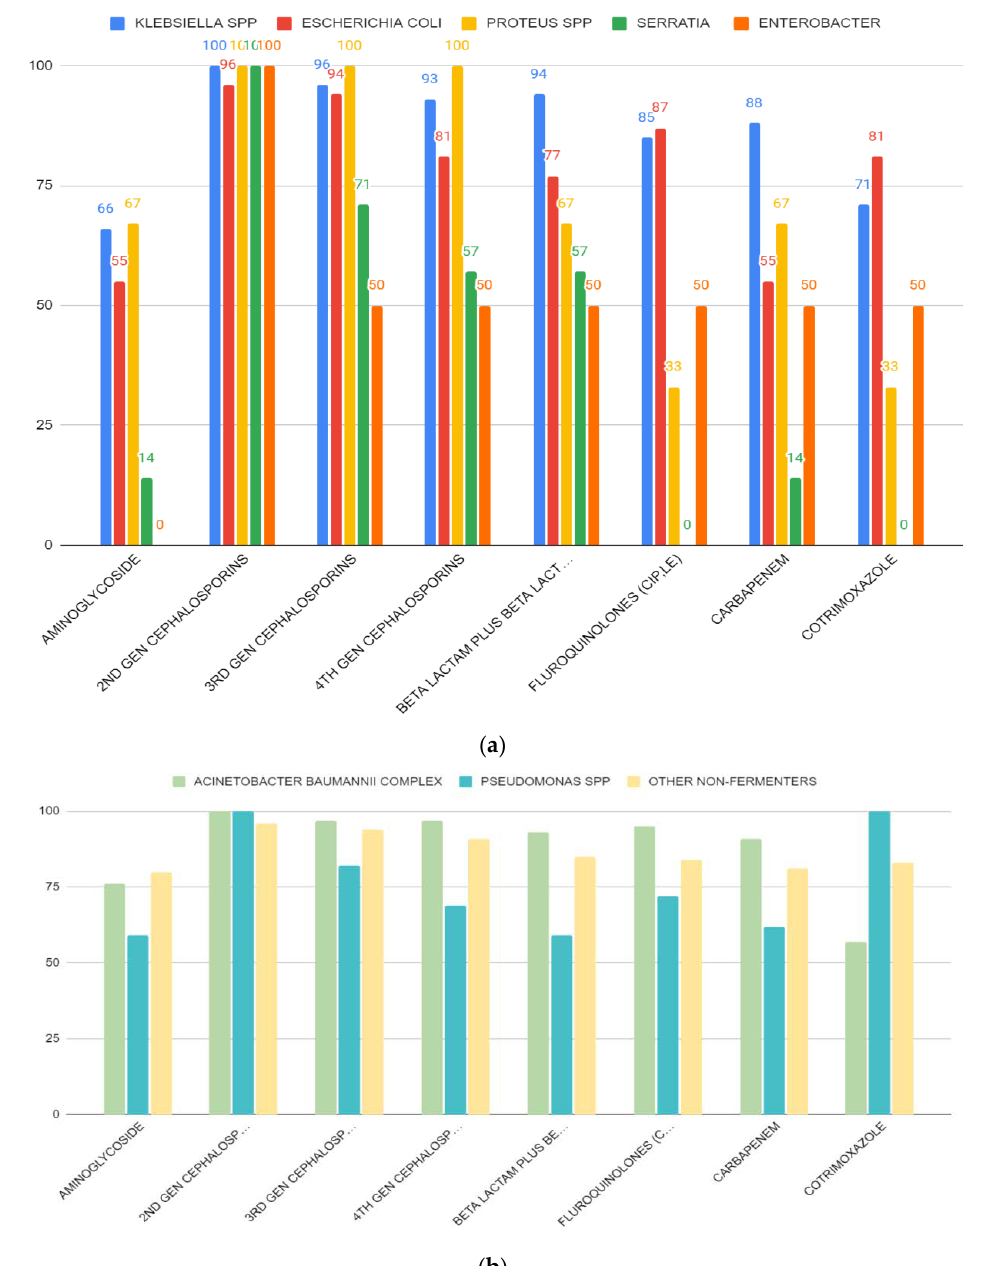
Figure 4. ( a ) Resistance patterns of isolated Enterobacteriaceae from different ICUs against different classes of antibiotics. Most of the microorganisms showed high resistance against cephalosporins. ( b ) Resistance patterns of non-fermenters isolated from different ICUs against some clinically relevant antibiotic classes.